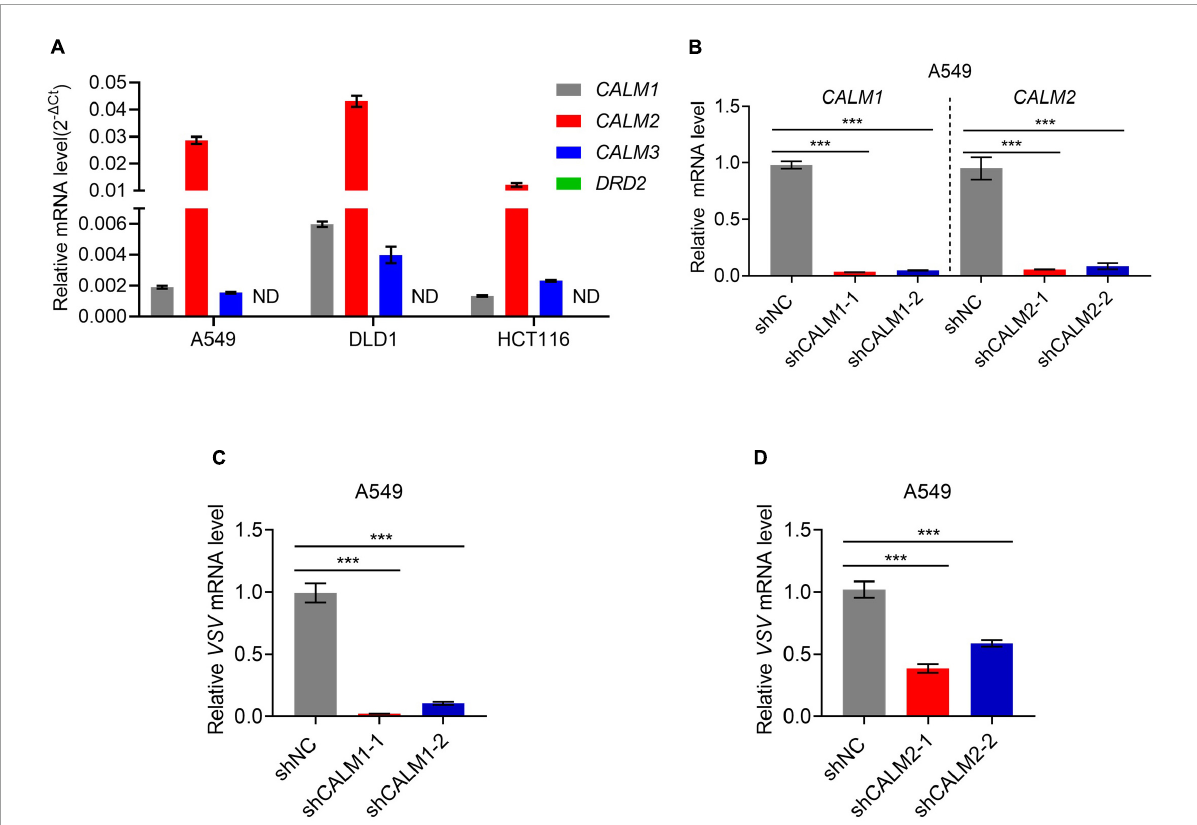
FIGURE3 Calmodulin is involved in the regulation of PERK-eIF2 α . (A) qPCR analysis of CALM1 , CALM2 , CALM3 , and DRD2 expression in A549, DLD1, and HCT116 cells. (B) qPCR analysis of CALM1 and CALM2 knockdown efficiency in A549 cells. (C) qPCR analysis of VSV mRNA expression of shNC, shCALM1-1, and shCALM1-2 A549 cells infected with VSV-GFP (MOI = 0.1) for 12 h. (D) qPCR analysis of VSV mRNA expression of shNC, shCALM2-1, and shCALM2-2 A549 cells infected with VSV-GFP (MOI = 0.1) for 12 h. *** p < 0.001 (one-way ANOVA with Bonferroni’s post-test). Data from three independent experiments [means ± SDs of triplicate assays (A–D) ] are